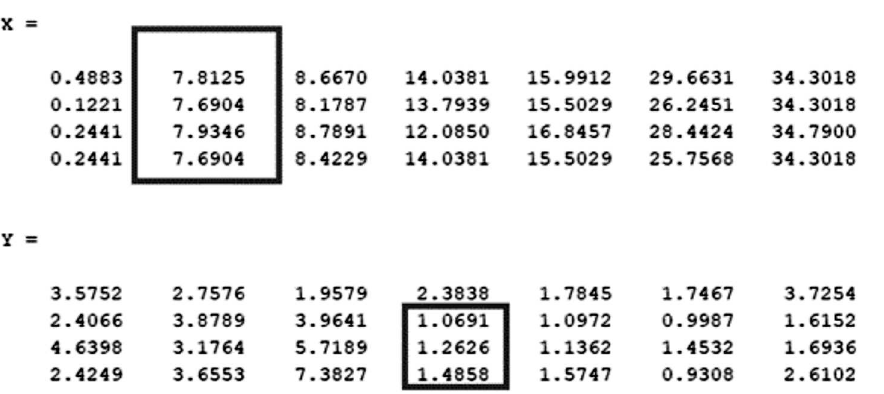
Figure 11. Sample matrix suggesting type III disorder